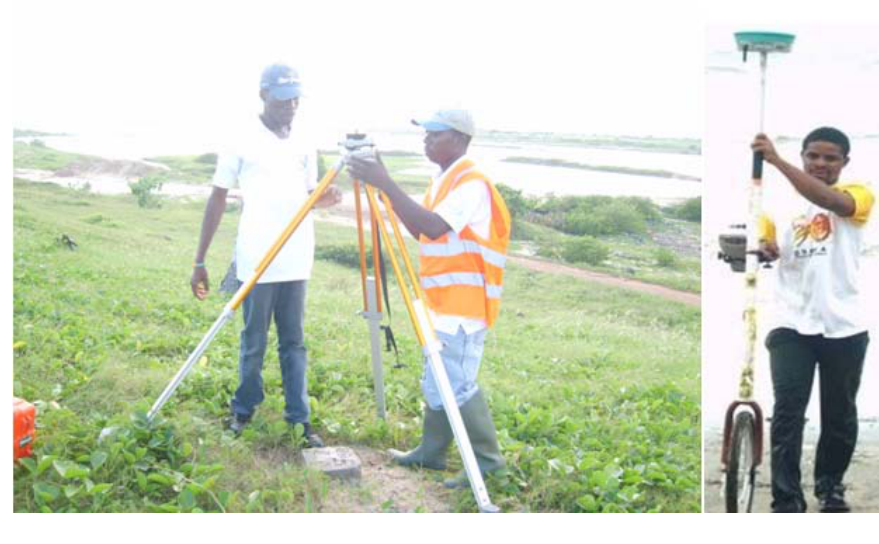
Figure 4. Kinematic GPS survey using a monocycle mounted with GPS